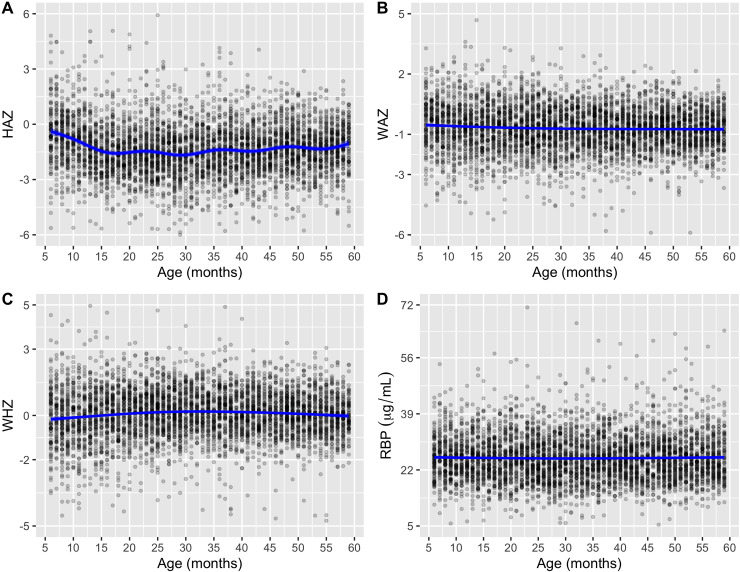
Z-score and blood RBP concentration as a function of age: Height-for-age Z-score (A), Weight-for-age Z-score, Weight-for-height Z-score (C) and serum RBP μg/mL in children aged 6–59 months. Data were fitted by thin plate regression spline. Growth faltering is seen according to the HAZ. Mean HAZ started below the standard with deficits ranging from -0.5 z-scores at 6 months to -1.5 z-scores at 18 months. Substantial variations were not observed in WAZ, WHZ, and RBP. Dots represent the individual child.